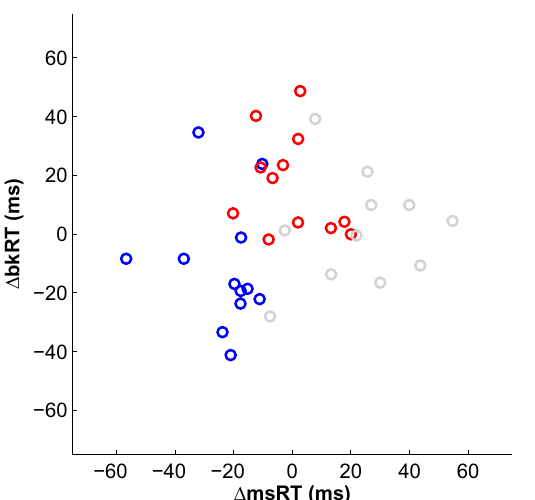
Figure 6. The relationship between msRT and bkRT, across subjects. ∆ msRT represents the timing of microsaccades in each condition, after subtracting the average msRT across all conditions. Similarly, ∆ bkRT represents the timing of blinks in each condition, after subtracting the average bkRT across all conditions. Each circle represents a single subject’s average ∆ msRT (x- axis) and ∆ bkRT (y-axis) in a single condition. Thus, for each subject, three dots are displayed, representing Invented-root (blue), Real-root (red) and Words (gray). There is a clear segregation between Real-root pseudowords and Invented-root pseudowords in the timing of both microsaccades and